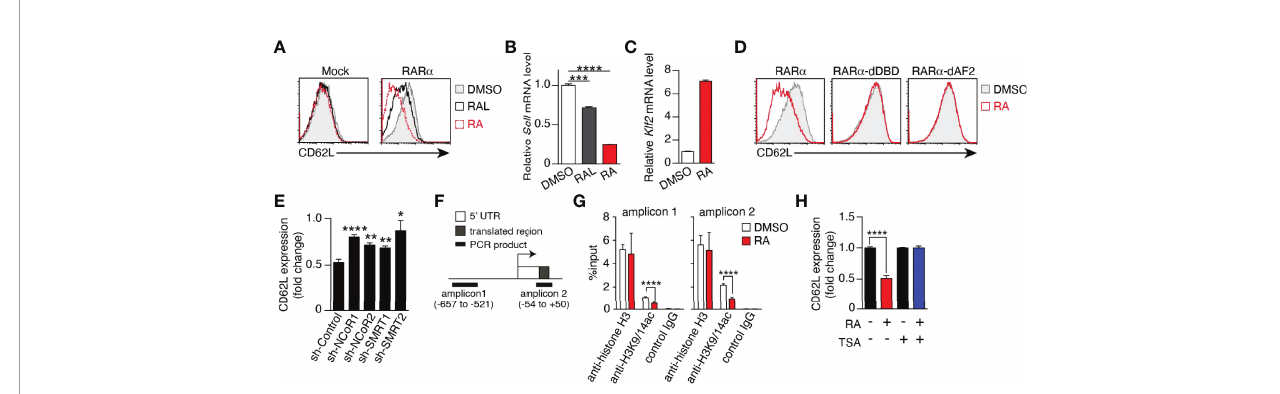
FIGURE 6 | RAR signaling-induced CD62L repression is mediated by epigenetic modi fi cations. (A – D) Jurkat cells transduced with the empty vector (Mock), full- length (RAR a ), DBD-de fi cient (RAR a -dDBD), or AF2-de fi cient RAR a (RAR a -dAF2) were cultured for 3 – 4 days in the presence of RAL (1 m M), RA (1 m M), or DMSO and the expression levels of CD62L protein (A , D) , CD62L mRNA (B) , and KLF2 mRNA (C) were measured. (A , D) Representative histograms are shown. (B, C) Representative CD62L and KLF2 mRNA levels in RAR a -overexpressing Jurkat cells after the indicated treatments. Representative data from two independent experiments are shown (A-D) . (E) RAR a -overexpressing Jurkat cells transduced with the indicated shRNAs were cultured for 4 days in the presence of RA (1 m M) or DMSO, and CD62L protein levels were measured. Data show the fold change of CD62L expression (MFIs of CD62L in RA-treated cells/those in DMSO-treated cells) in three independent experiments. (F) CD62L locus and positions of amplicons for the ChIP assay. (G) ChIP assay results from RAR a -overexpressed Jurkat cells treated with DMSO or RA for 4 days. Data were obtained from two (DMSO) or three (RA) independent experiments. (H) CD62L expression (fold change) on RAR a - overexpressing Jurkat cells cultured under the indicated conditions (RA, 1 m M; TSA, 50 nM) for 4 days. Data were obtained from three independent experiments. Data were analyzed by unpaired t-tests. Error bars show s.e.m. *p < 0.05; **p < 0.01; ***p < 0.001; ****p <